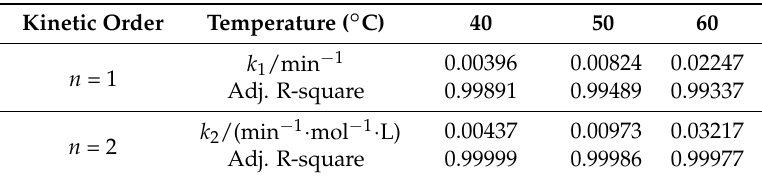
Table 2. Kinetic rate constants ( k 1 , k 2 ) and linear fitting values ( R ) describing the kinetics of model DA reaction.